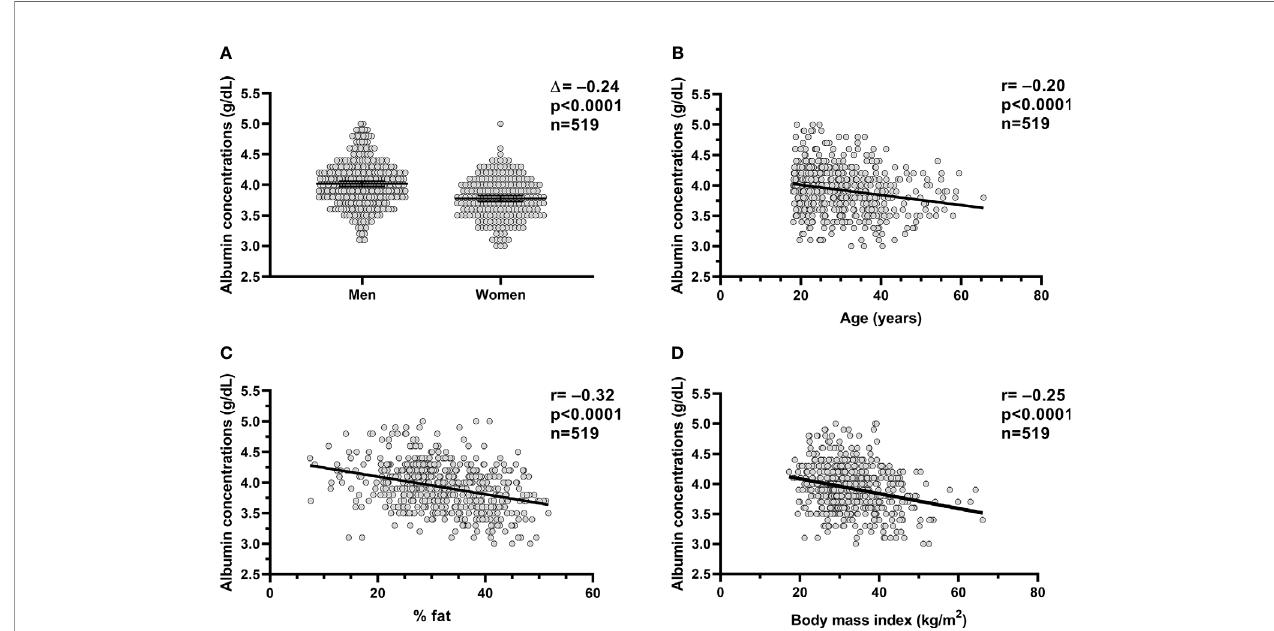
FIGURE 1 | Relationships between plasm albumin concentrations and body composition and age. Relationships between plasma albumin concentration (g/dl) and sex (A) , age (B) , percent body fat (C) and BMI (D) . In each panel, the Pearson ’ s correlation coef fi cient (r) is reported along with its signi fi cance (p). The dots in each panel are referring to the volunteers (n=519) who completed the inpatient part of the studies ( study 1 and study 2 ). %fat, percentage body fat; BMI, body mass